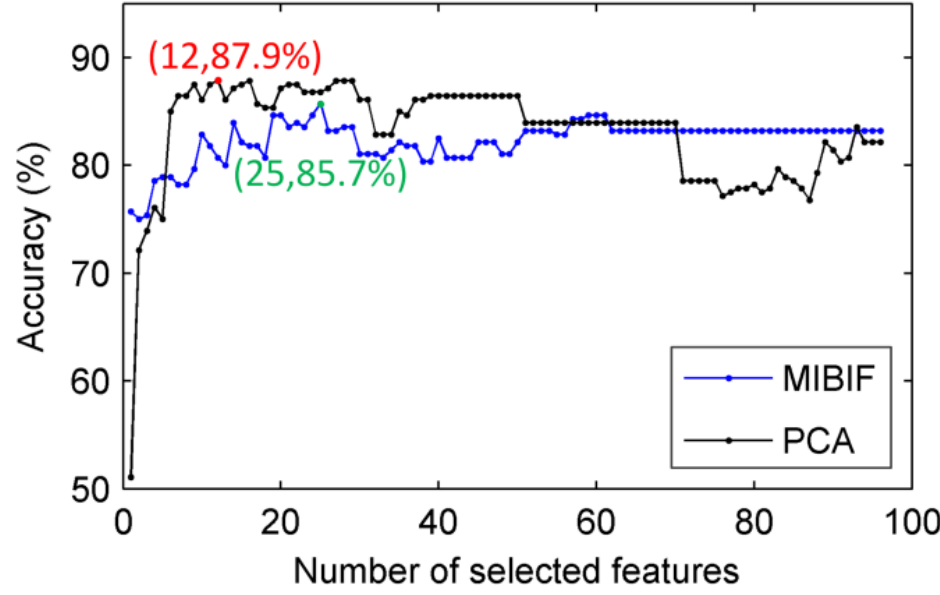
Figure 9. Classification accuracy over the number of selected features by MIBIF and PCA for subjects av.